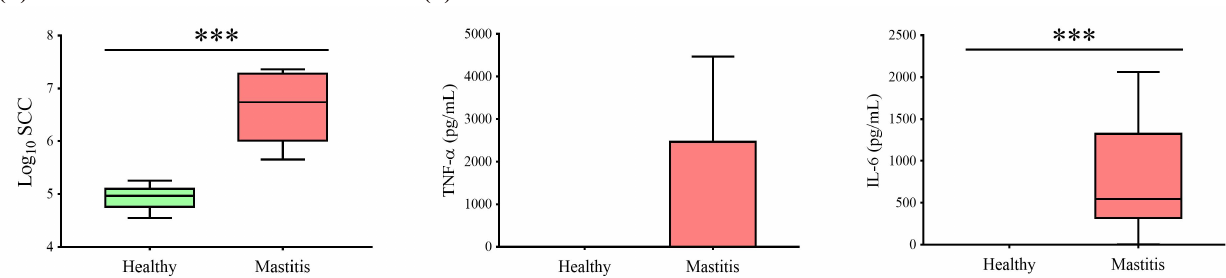
Figure 1. Somatic cell counts and serum cytokines of healthy and mastitic cows. ( A ) Log-transformed somatic cell counts and ( B ) serum cytokines (TNF- α and IL-6) were significantly higher in mastitic cows than in healthy cows (*** p < 0.001).